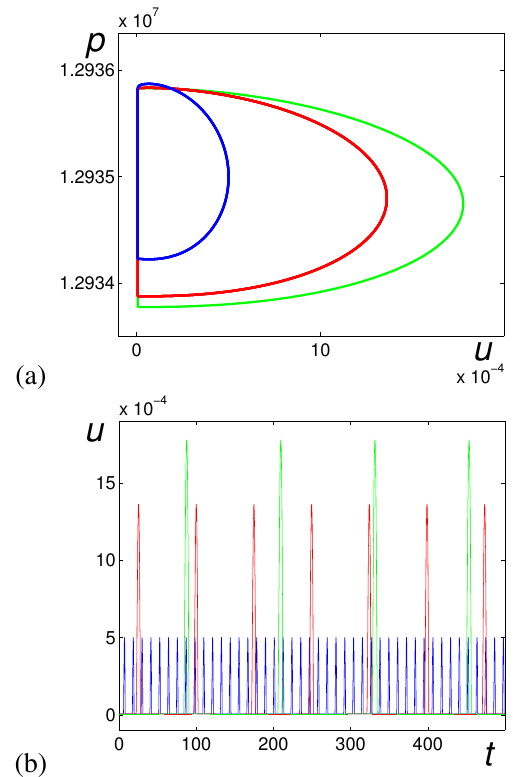
Figure 4. (a) illustrates a projection of the phase portrait p (Pa) vs. u (ms − 1 ) of the deterministic system. (b) shows u (ms − 1 ) as a func- tion of t (s). These dependencies are plotted for different values V 0 : V 0 = 10 5 m 3 (blue), V 0 = 6 . 32 × 10 5 m 3 (red), and V 0 = 10 6 m 3 (green).